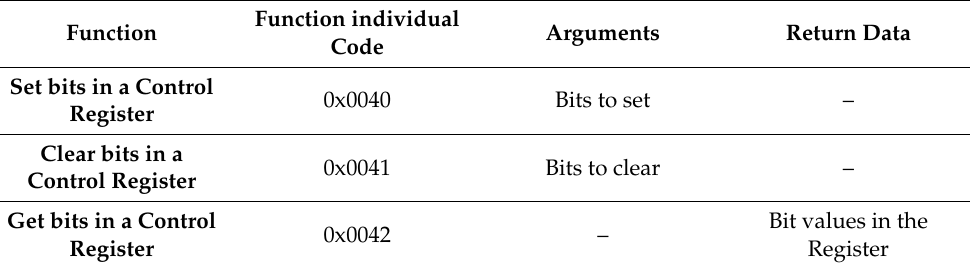
Table 3. List of CAN transactions for setting bits in Control Register.